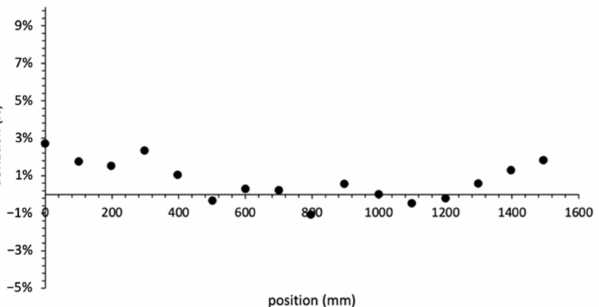
Figure 12. Relative deviation ∆ D z in % between the air kerma measured by IVISCAN ® and the reference for each z-axis irradiation position along the PSF; 1000 mm corresponds to the PSF